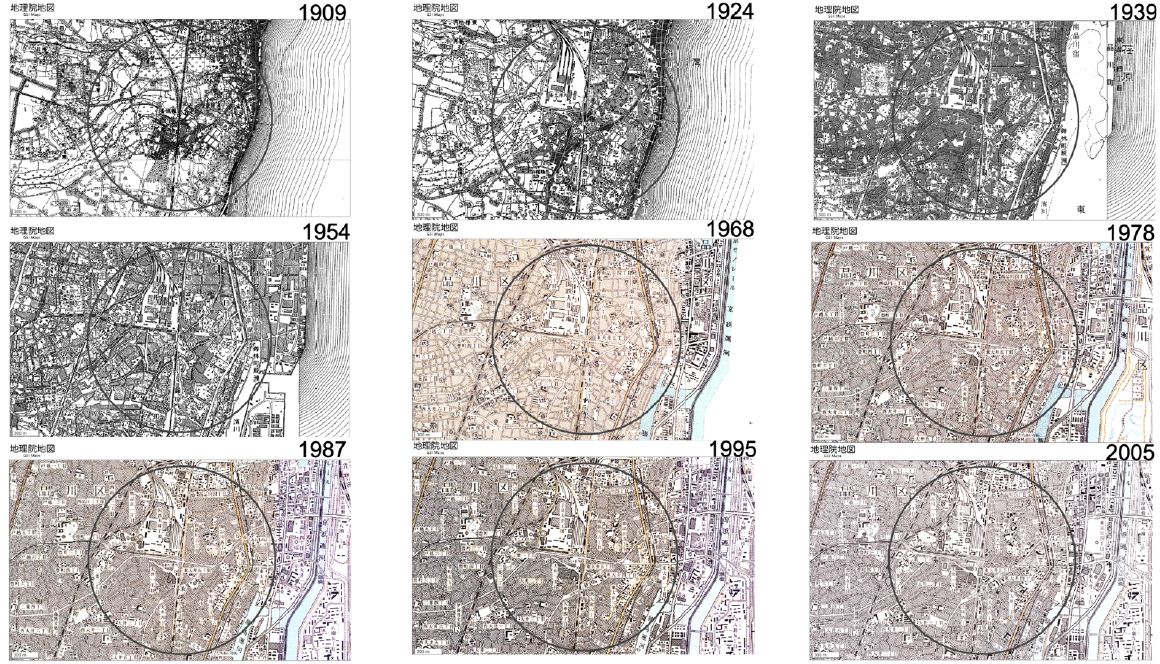
Figure 9. Diachronic mapping 1909–2005, indicating urban changes. Source: Courtesy of the Geospatial Information Authority of